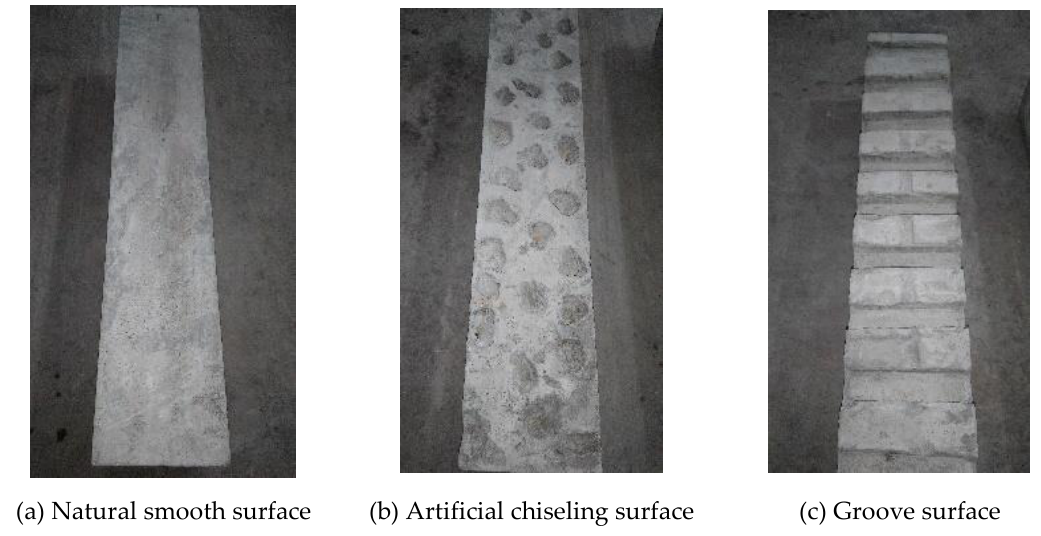
Figure 4. Bonding surface of old concrete after treatment.